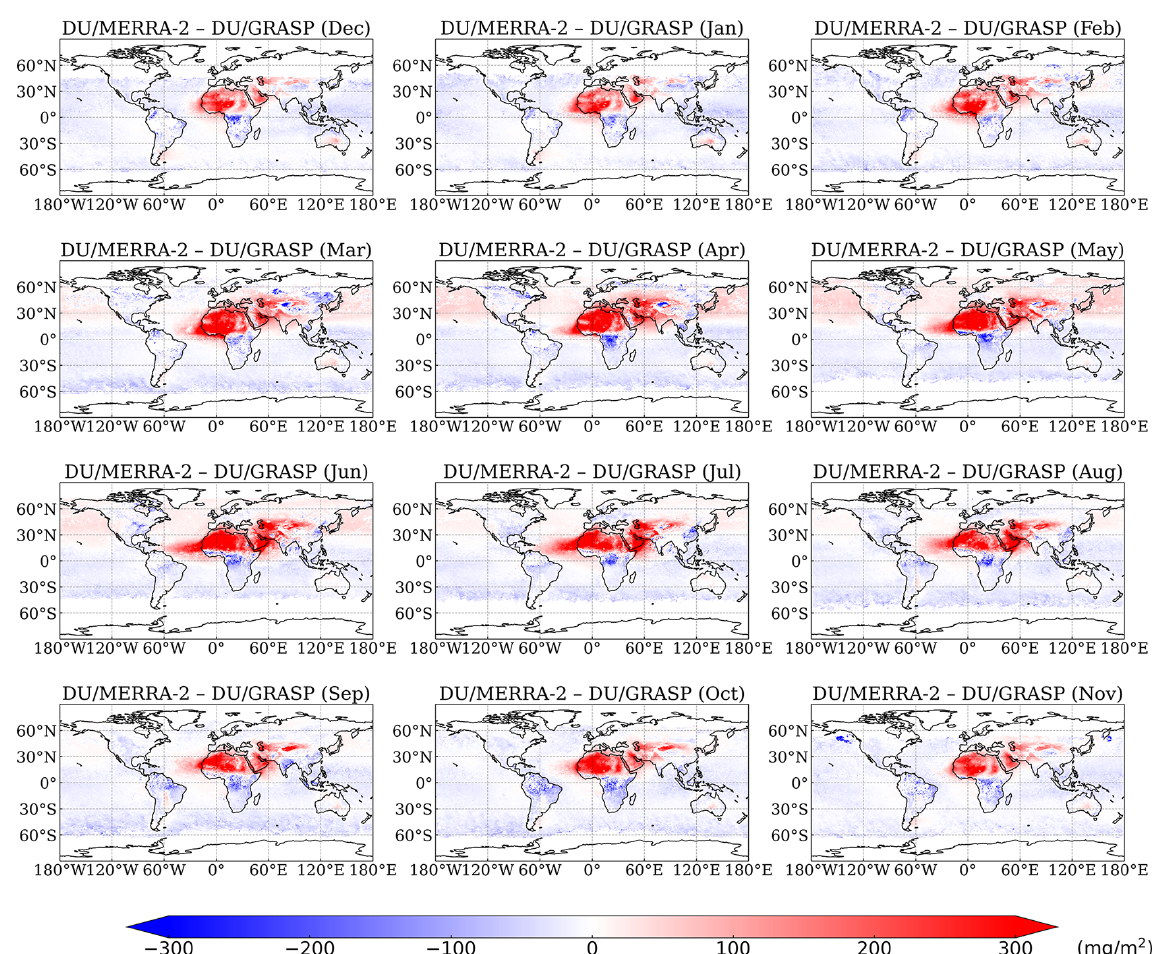
Figure 20. Differences of monthly dust column concentration between GRASP/Component and MERRA-2 in the resolution of 0 . 5 ◦ × 0 . 625 ◦ for the period March 2005–October